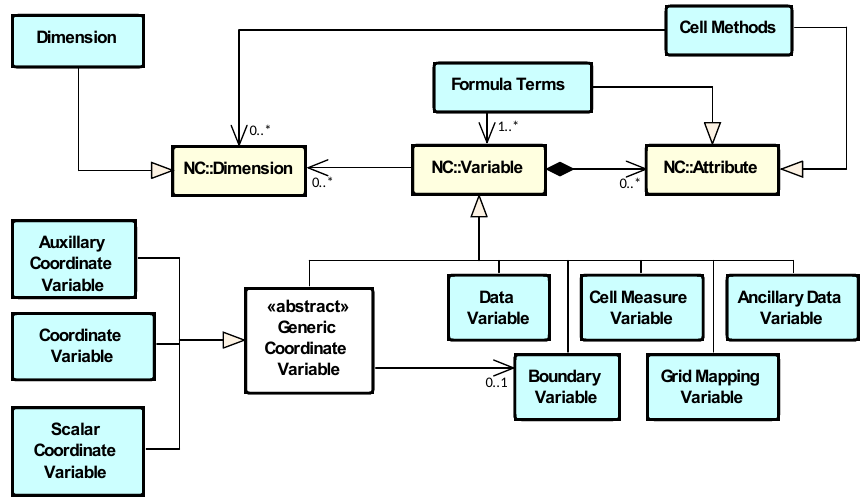
Figure 8. The relationships between CF-netCDF elements (corresponding to the blue CN layer in Fig. 1) and their corresponding netCDF variables, dimensions, and attributes (the yellow NC layer in Fig. 1) described using UML (Appendix A). It is useful to define an abstract generic coordinate variable that can be used to refer to coordinates when the their type (coordinate, auxiliary, or scalar coordinate variable) is not an issue. The CF convention details the mechanisms which are used in the netCDF file to express the relationships among the CF-netCDF elements, but these are not shown in the